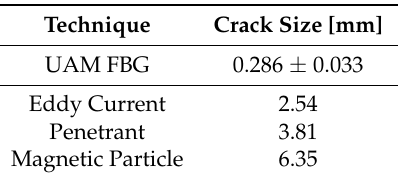
Table 2. Comparison of minimum detectable crack size between UAM-embedded FBG sensors and common aerospace NDI techniques [32].